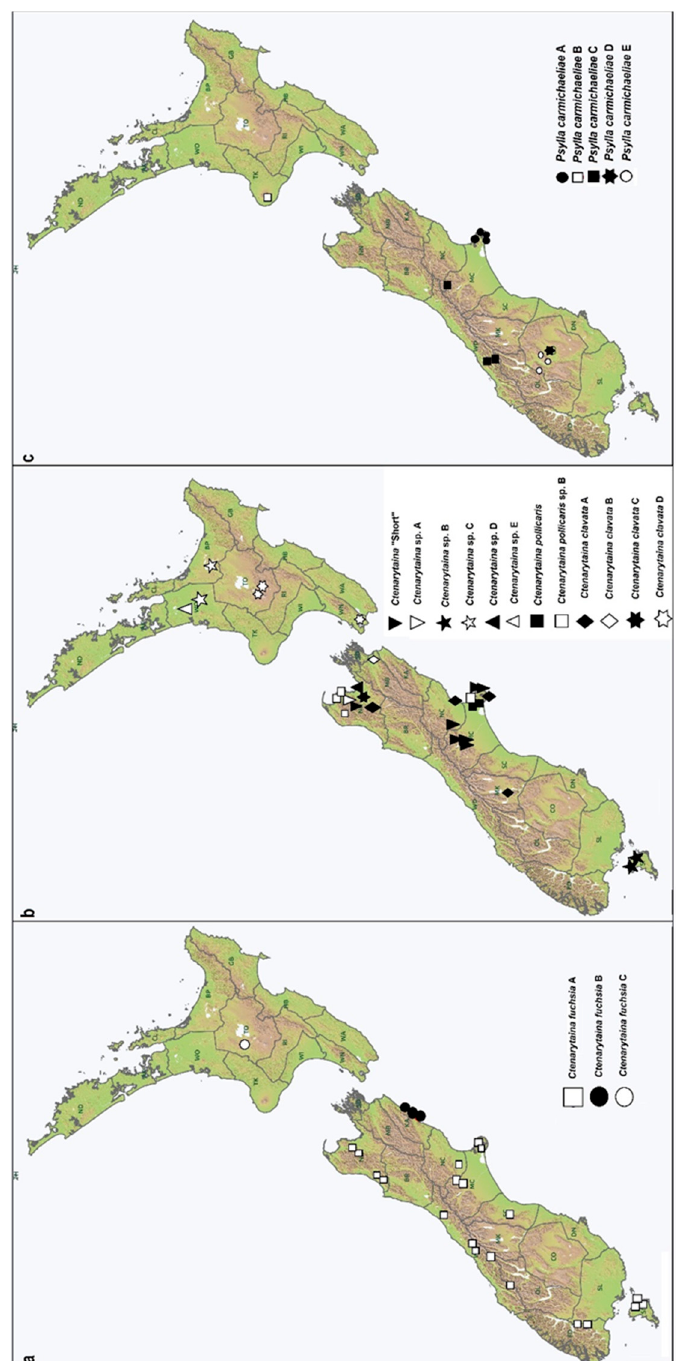
Figure 3. Distribution of the newly discovered cryptic taxa across New Zealand: Ctenarytaina taxa on Fuchsia ( a ) and on the m ā nuka and k ā nuka tea trees ( b ); and Psylla spp. on Carmichaelia ( c ). 3.2.1. The Genus Psylla Showed Examples of Putative Host Plant Specificity and a Syntopic Distribution